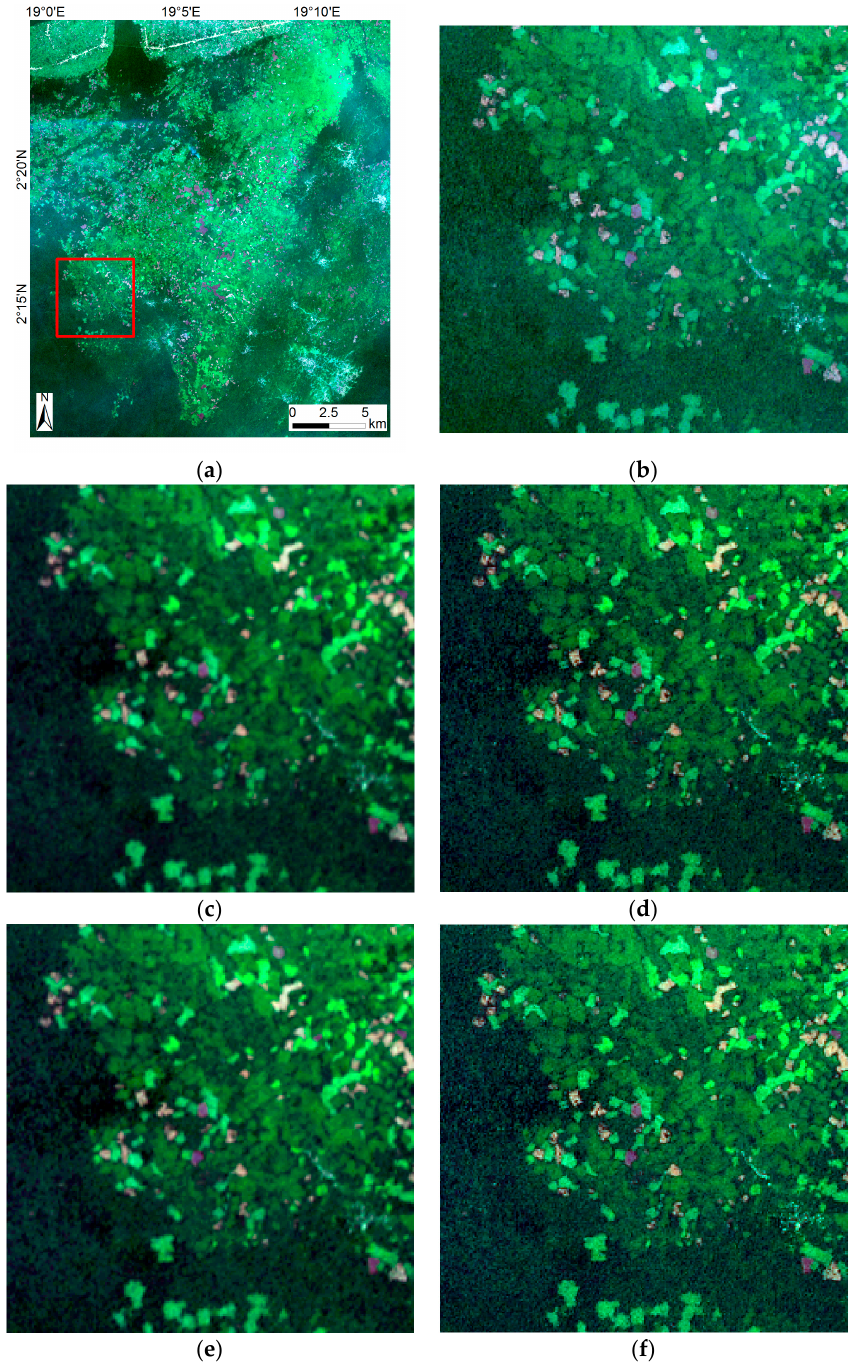
Figure 8. Tropical forest, Democratic Republic of the Congo, true color images showing: ( a ) Sentinel-2A 20-m image (1230 × 1425 20-m pixels) and sub-set (red box); ( b ) Sentinel-2A 256 × 256 20-m pixel sub-set; ( c ) Landsat-8 bilinear resampled to 20 m; ( d ) Landsat-8 bilinear-based LPAD 20-m data; ( e ) Landsat-8 cubic convolution resampled to 20 m; ( f ) Landsat-8 cubic convolution-based LPAD 20-m data. The smoke aerosols present in the Sentinel-2A image are evident in the north and west of ( a ).